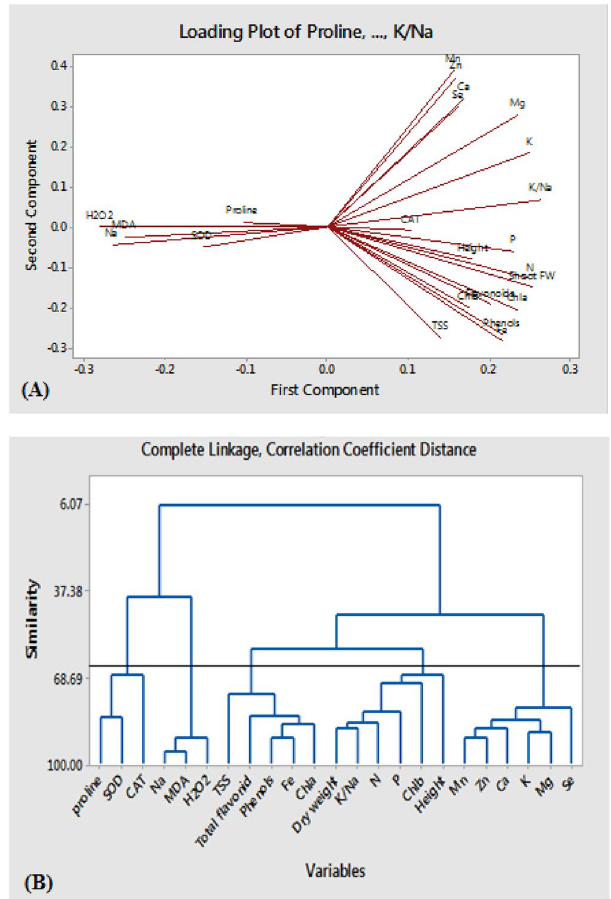
Figure 6. The loading plot for the evaluated traits of grapevine cv. Sultana under salinity and treated by Se and nano-Fe included in principal component analysis. The studied traits included TSS (total soluble solids), Chl a (chlorophyll a), Chl b (chlorophyll b), Chl T (total chlorophyll), CAT (catalase activity), SOD (superoxide dismutase activity), MDA (malondialdehyde content) ( A ). The cluster dendrogram is based on the Ward method among evaluated traits of grapevine cv. Sultana under salinity and treated by Se and nano-Fe. The studied traits included TSS (total soluble solids), Chl a (chlorophyll a), Chl b (chlorophyll b), Chl T (total chlorophyll), CAT (catalase activity), SOD (superoxide dismutase activity), MDA (malondialdehyde content) ( B